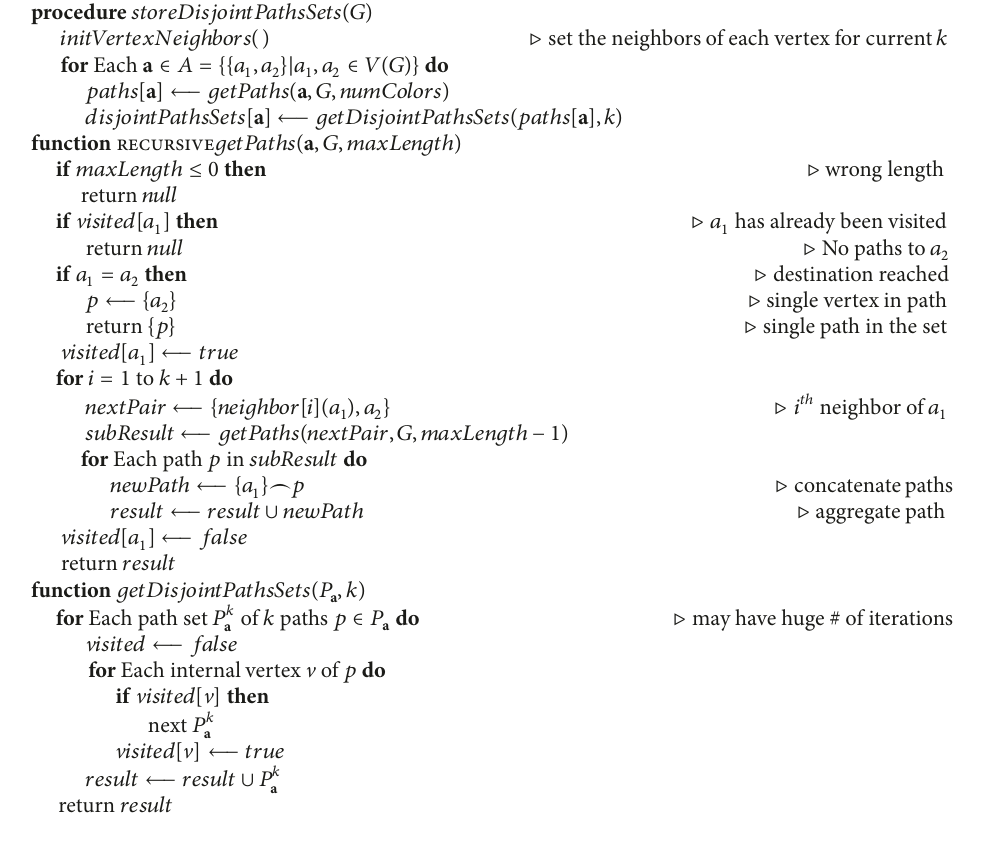
Algorithm 3: Disjoint paths sets between vertices.